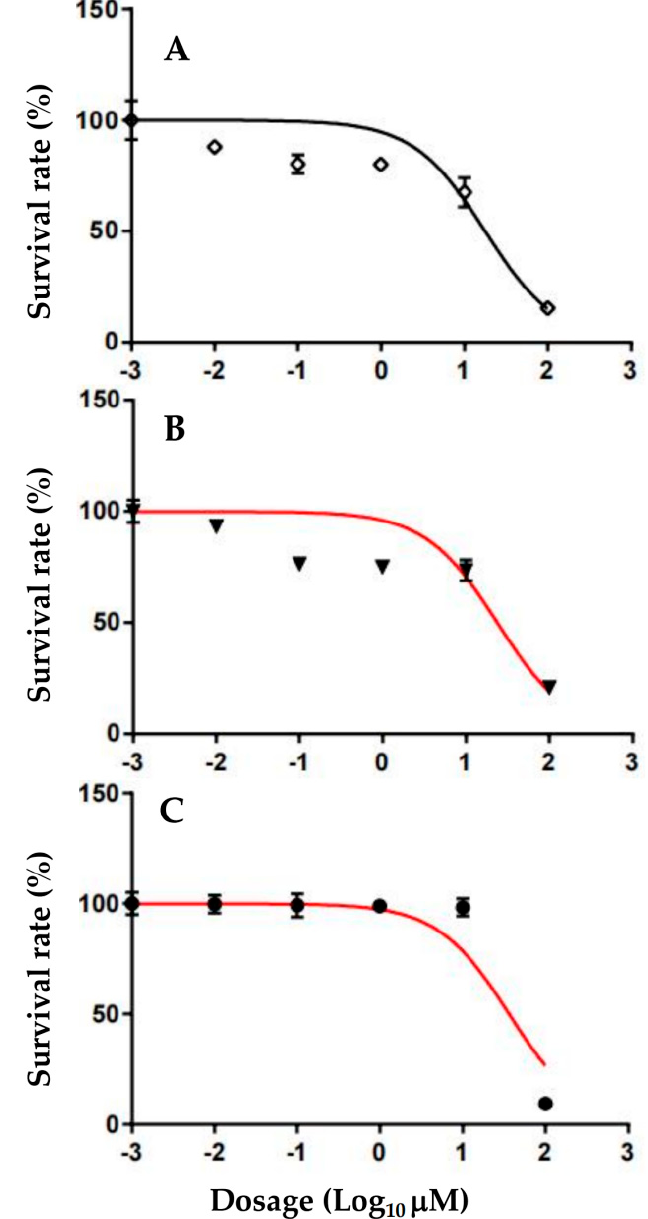
Figure 4. Loss of MCF-7 cell viability produced by compounds 5b 5d , and 5f . MCF-7 cells were exposed to 5b ( A ), 5d ( B ), and 5f ( C ) for 72 h and the viability of cells was analyzed by Alamar Blue assays. The results are presented as mean ± S.E.M. of triplicate determinations. Furthermore, we tested the most active compounds such as 5b , 5c , 5e , and 5f for the ability to inhibit human breast cancer cells’ (T47D, BT-474, SKBR3, and MDA-MB-231) proliferation (refer supplementary data). Around 2000 cells per well seeded overnight were treated with the compounds with 2% FBS conditioned medium and incubated for 3 days. The analysis of the IC 50 s of lead pyranopyrazoles revealed that the compounds could inhibit the proliferation of BT-474 cells effectively (Table 3). The tested pyranopyrazoles failed to inhibit the human breast derived normal